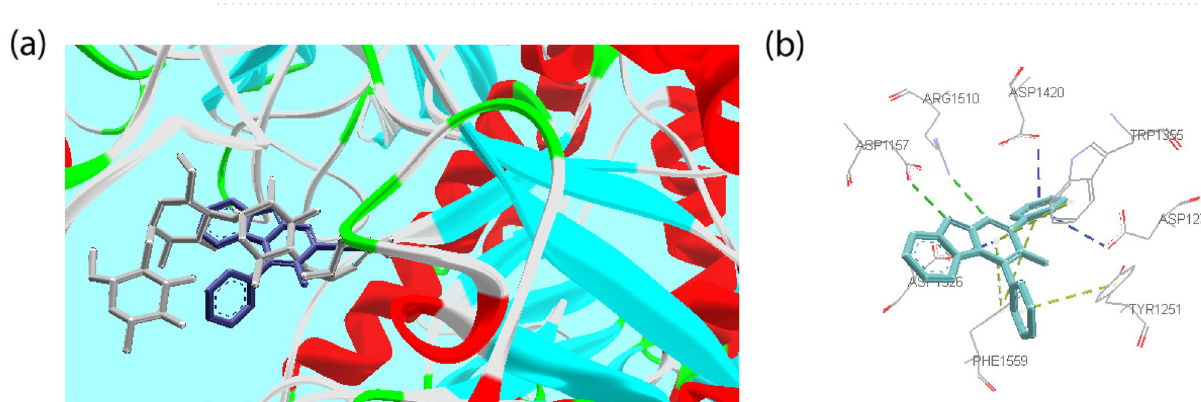
Figure 7. ( a ) Acarbose (gray) and compound 3a (blue) superimposed in the human intestinal α-glucosidase active site. ( b ) 3D predicted binding mode of the compound 3a in the human intestinal α-glucosidase active site (H-bond: green, π–π: yellow, π-Anion: blue). *This figure was created by using Discovery Studio 4.0 Client (https:// disco ver. 3ds. com/ disco very- studio- visua lizer- downl oad) and LigPlot (https:// www. ebi. ac. uk/ thorn ton- srv/ softw are/ LigPl us/ downl oad.